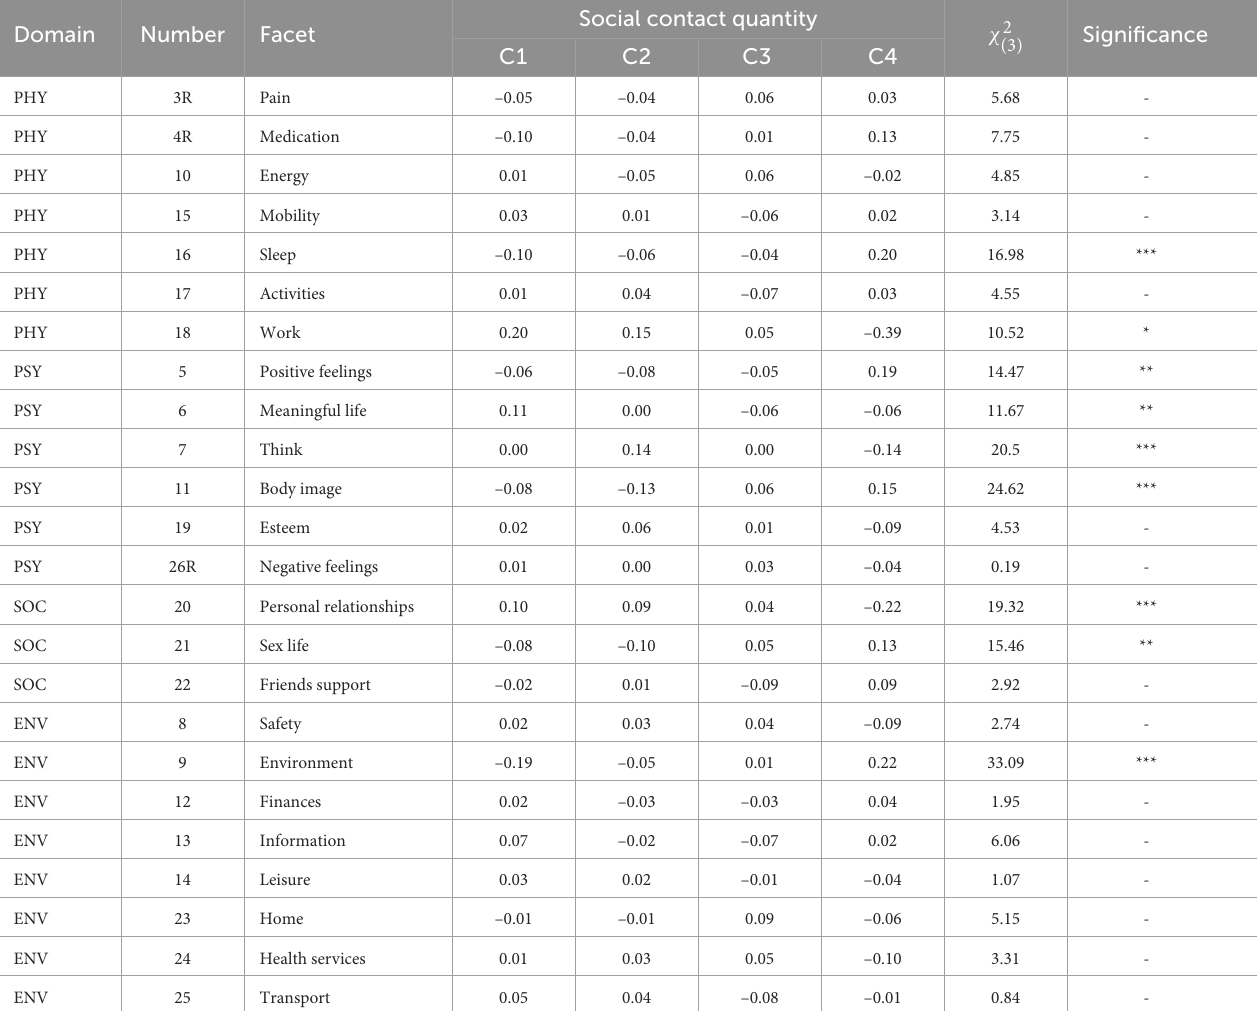
TABLE 4 Summary table for the DIF analysis in the items of the WHOQOL-BREF across subgroups of social contact